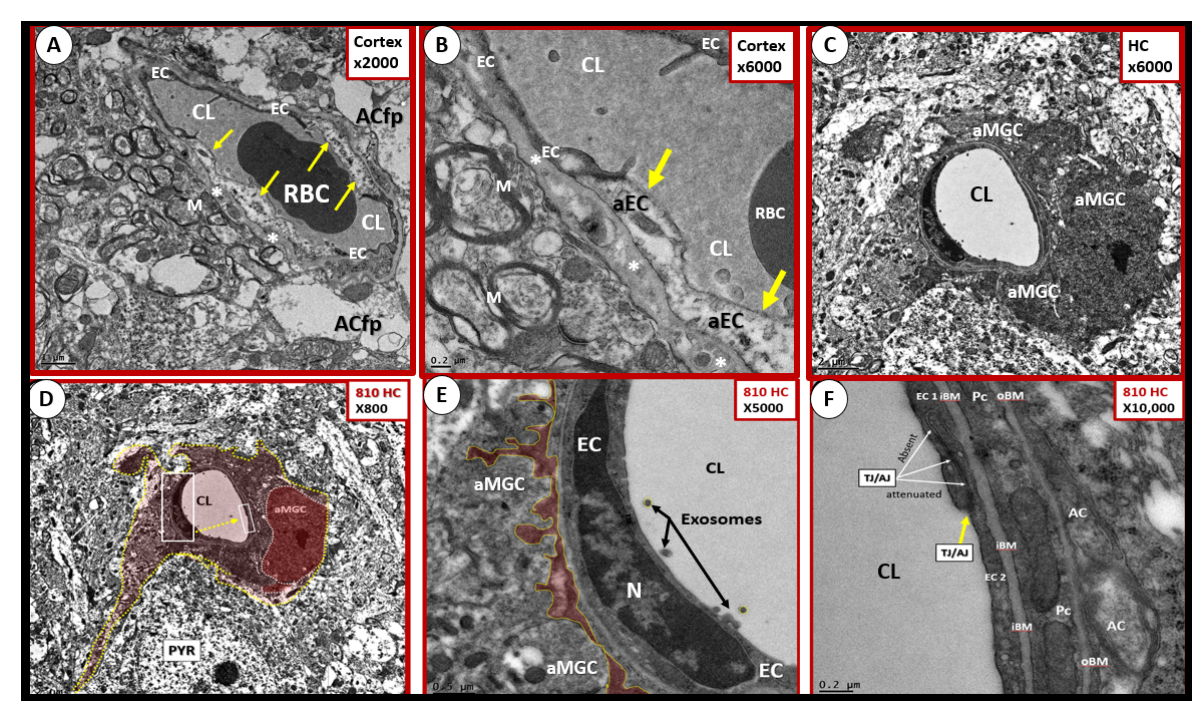
Figure 10. Endothelial and microglial activation in cortical and hippocampal NVUs of the BTBR ob/ob model. Panels A and B depict swollen electron lucent activated endothelial cells (aECs) and thickened basement membranes of cortical Layer III. Note the vacuolization of the BM in Panels A and B (asterisks). Magnification ×2000 and ×6000 respectively. Panels C through F depict an aMGC encroaching between the BEC and the rest of the NVU. Panels C and D depict an aMGC with loss of pericytes and astrocytes. Panel D (a lower magnification of Panel C) illustrates the aMGC pseudo-colored red and its relation to a pyramidal cell (PYR). Panel E depicts aMGC cytoplasmic processes (pseudo-colored red) directly abutting the ECs basement membrane and is a higher magnification of boxed in region in Panel D. Furthermore, note the exosomes within the capillary lumen that are between 50–75 nm in diameter, which may indicate stressed EC activation. Panel F illustrates that while these endothelial changes are occurring to the left and inferior NVU, the right or opposite side of the endothelial lining depicts the tight and adherens junction (TJ/AJ) remaining intact (arrows). Various magnifications labeled upper right and scale bars in each panel in lower left. ACfp = astrocyte foot processes; aMGC = activated microglial cell; CL = capillary lumen; iBM = inner basement membrane; M = myelin; n = nucleus; oBM = outer basement membrane; PYR = pyramidal cell; RBC = red blood cell. TJ/AJ = tight junctions/adherens junctions.